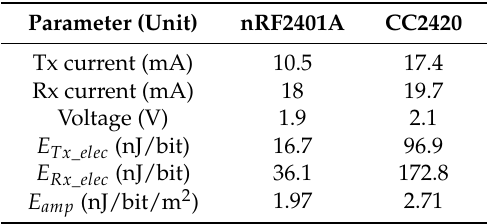
Table 5. Radio parameters of nRF2401A and CC2420.